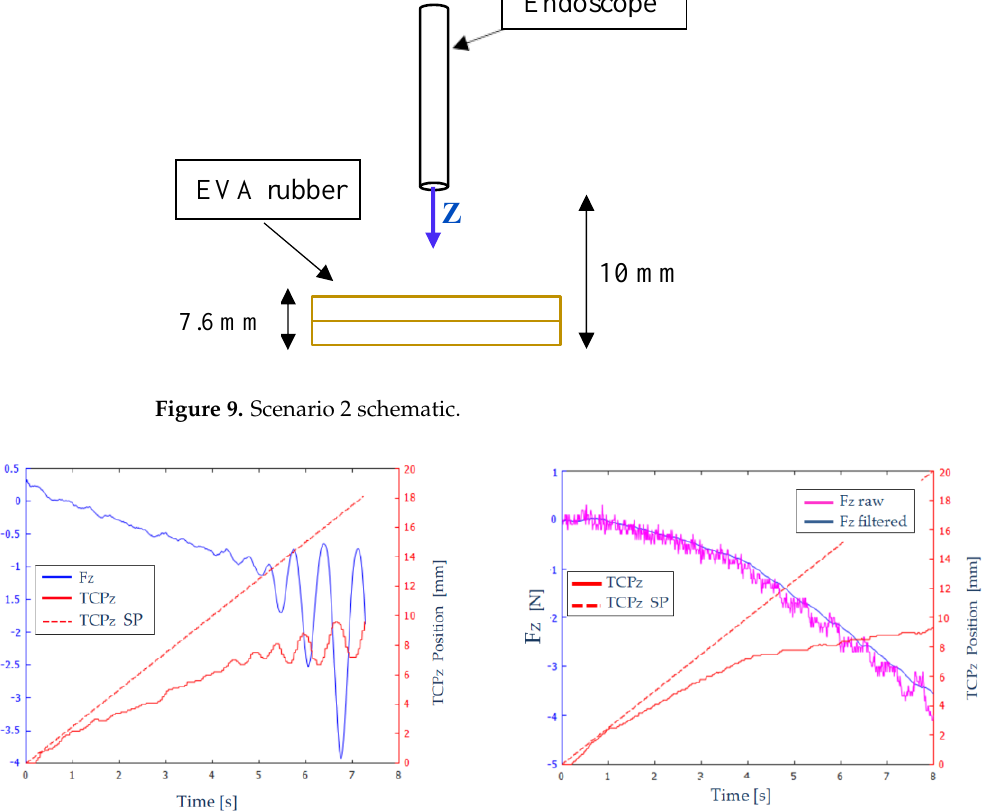
Figure 9. Scenario 2 schematic.